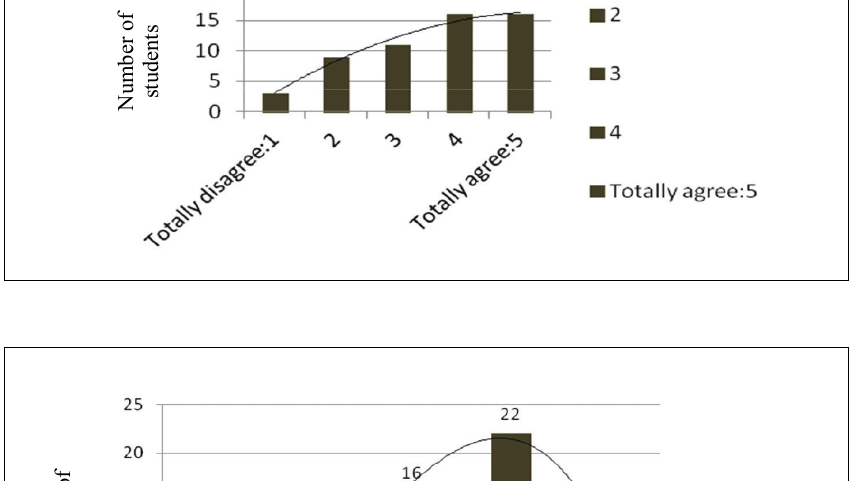
Figure 5. Response to Statement 1 “In my neighbourhood everyone can do sport he/she likes”